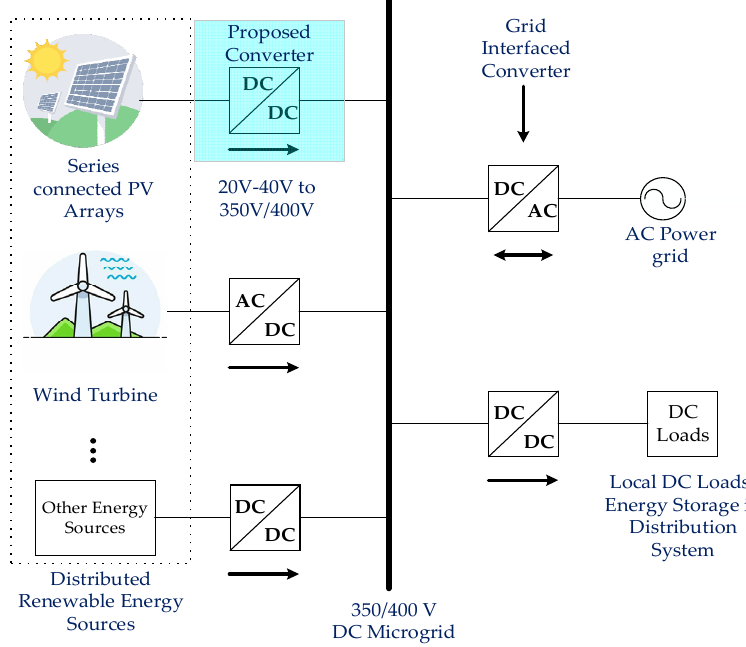
Figure 1. Schematic diagram of a microgrid system. Level three rapid charging for electric vehicles (EVs) uses high-gain converters. In islanded mode functioning of a DC microgrid, AC loads can be fed by combining a high- gain converter with an inverter. High-gain converters have become more popular, because conventional boost converters and their variations are inefficient and have to work with a high-duty cycle to achieve a high gain [27]. Additionally, there is an issue with the diode reverse recovery when the duty cycle increases. One can essentially categorize these converters as either non-isolated or isolated. To prevent the current from flowing directly from the output to the input, isolated converters physically separate the circuit into two halves. Using a high-frequency transformer accomplishes this at the expense of the converter’s size and cost [28–30]. In high-power applications and those requiring a common ground between the source and the load, isolated topologies are preferred. Where input and output isolation are not necessary, non-isolated converters are preferred. It is possible to divide them into coupled and uncoupled types [31]. While coupled inductor topologies have the potential to generate a very high voltage gain with minimal stress on the switch, issues with leakage inductance can cause huge voltage spikes across the switch, necessitating the design of a clamped circuit. Cascading two or more converters creates a high-gain capacitor diode voltage multiplier cell. Some novel and modified topologies include a voltage multiplier circuit (VMC) designed from switched inductors and capacitors to boost the gain of the converter. A high gain can be achieved with low-duty cycles and less stress on semiconductor switches using the cubic boost and quadratic boost converter (QBC) topologies [32–34]. Although the efficiency may drop with increasing the current at greater duty ratios. The inductor current ripple and switch stress were both reduced in a novel QBC suggested in [35]. Interleaved boost converters were also employed to achieve a high output voltage and higher efficiency [36] with the reduced number of switches. It is possible to attain a high gain with a multiphase interleaved converter by incorporating a Z-source network. Since the ripple in the input current is so low, there is no requirement for an input ripple filter. The issue with interleaved converter topologies is that they require a voltage boost circuit at the end to make the